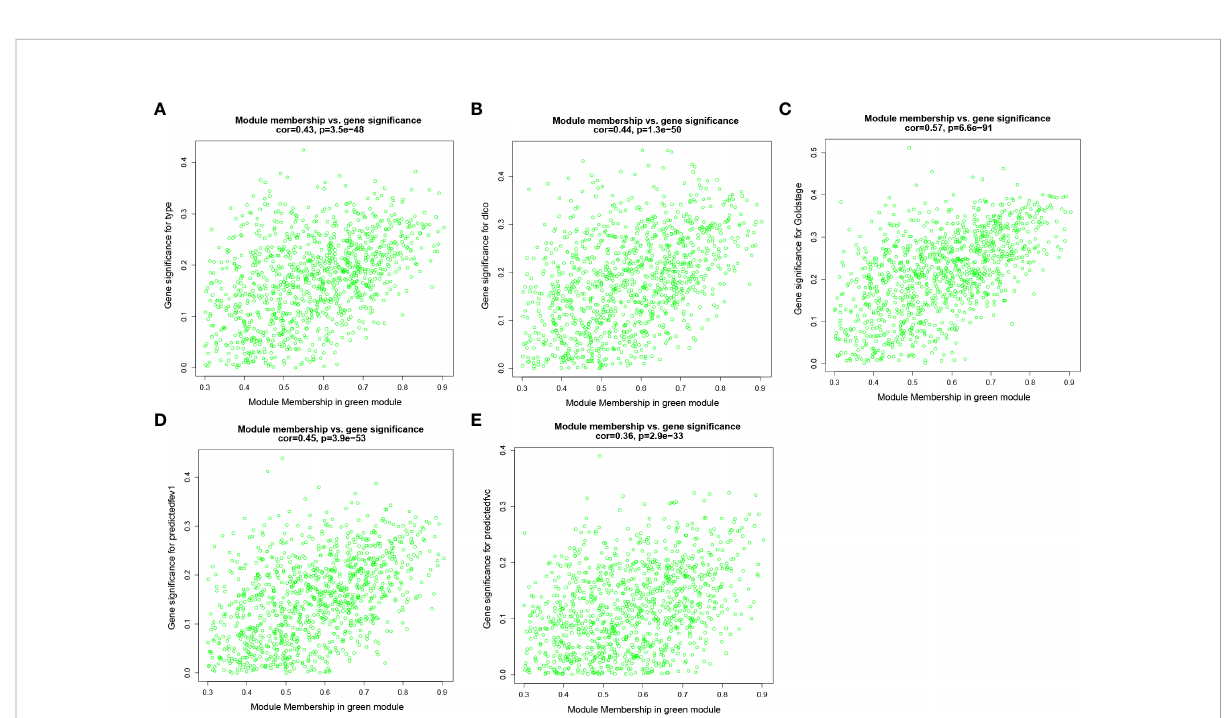
FIGURE 8 Weighted co-expression network analysis. Scatter plot of genetic signi fi cance of emphysema phenotype (A) , DLCO (B) , GOLD Stage (C) , FEV1 post-bronchodilator % predicted (D) and FVC post-bronchodilator % predicted (E) vs . Module Membership in green